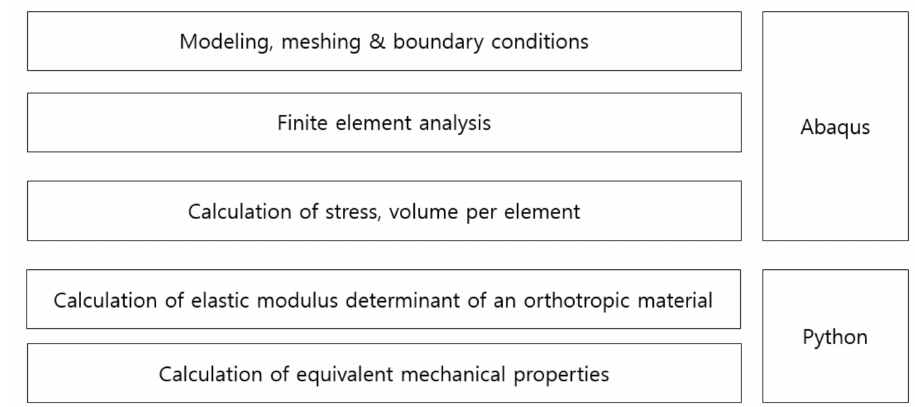
Figure 9. The procedure of calculation of equivalent mechanical properties. When simulating the circular pores, the length of cubic was 221.25 µ m and the diame- ter of hole was 116.25 mm, which was based on real specimen. The size of mesh was 5 µ m, and the shape of mesh was hexagonal grid with reduced integration (C3D8R), which is shown in Figure 10. Moreover, the number was mesh is over 76,000.